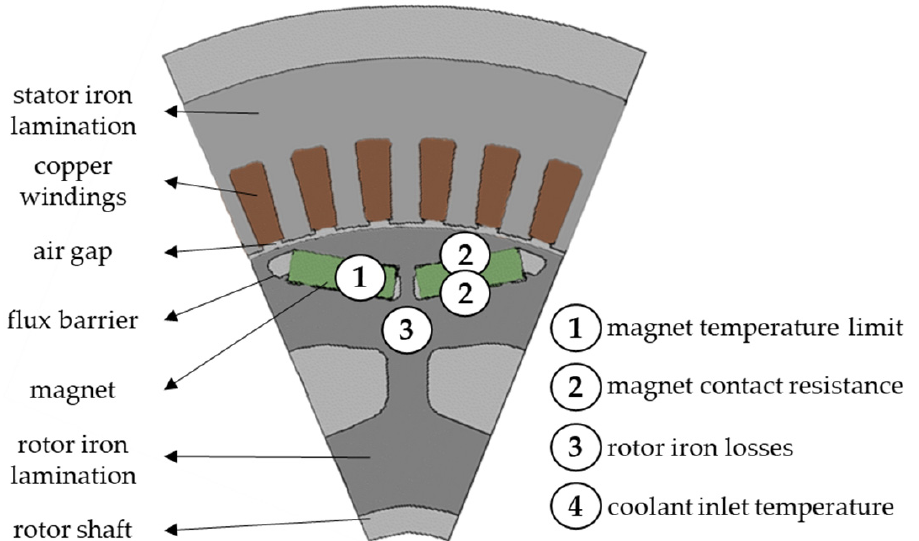
Figure 10. Schematic illustration of the cross-section of the electrical machine and of the parameters that influence the thermal performance of the rotor.